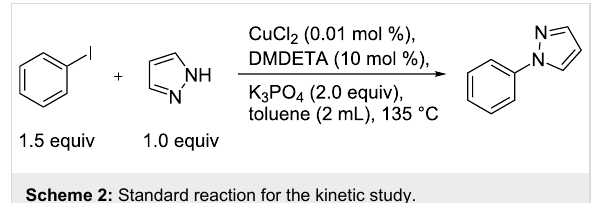
insoluble aggregates at high concentration [87] is avoided.